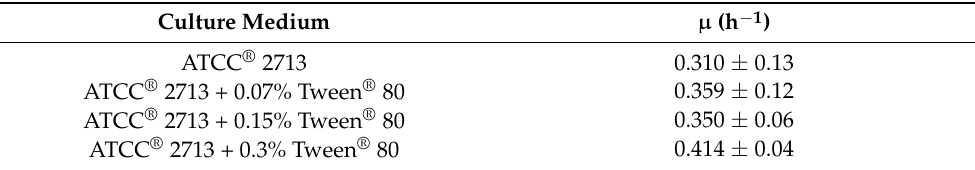
Table 1. Specific Clostridium carboxidivorans growth rate in ATCC®2713 medium with different concentrations of Tween® 80.